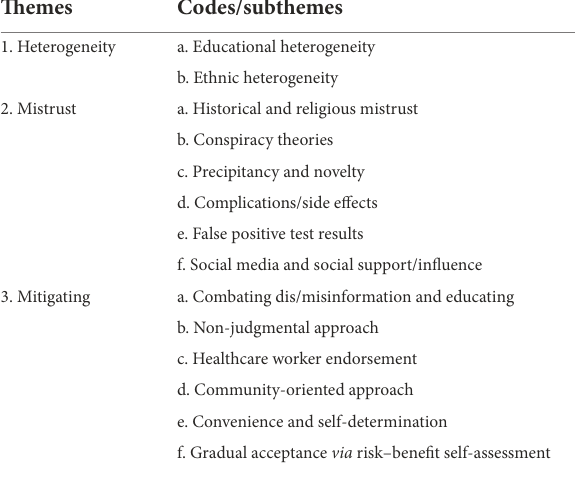
TABLE 3 CVH themes and